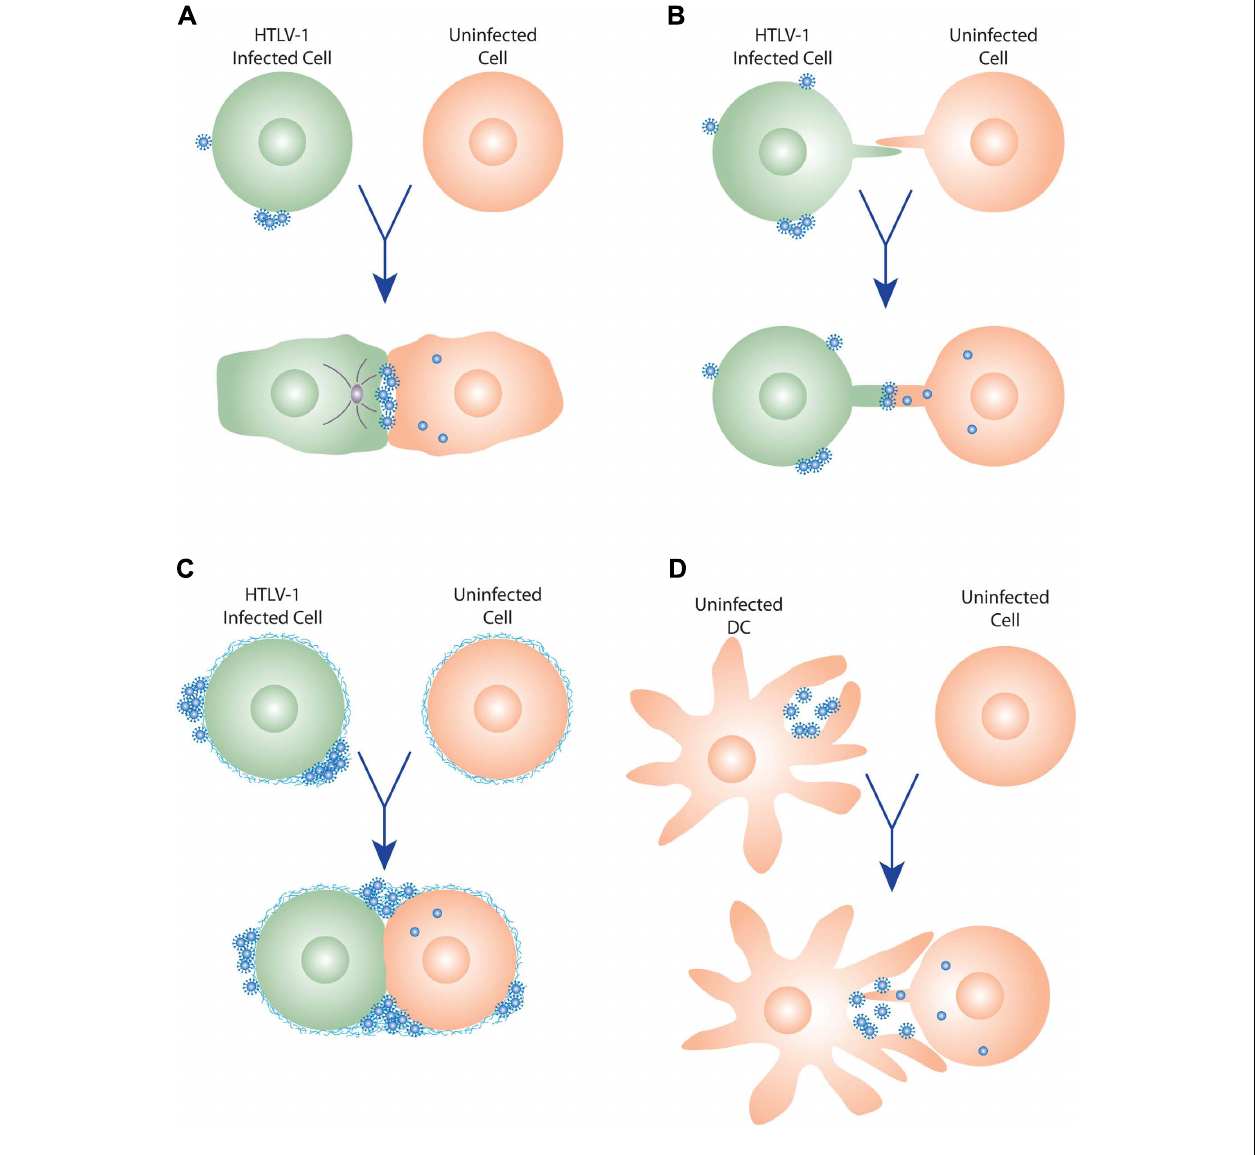
FIGURE 1 | Models of HTLV-1 cell–cell transmission. (A) Virological synapse.When HTLV-1-infected cells contact uninfected cells, the virological synapse (VS) is formed by specific interactions between proteins on the infected and uninfected cells, and the MTOC (gray circle) is reoriented towardVS.Viral budding is polarized to the virological synapse, and the newly budded viruses enter the synaptic cleft formed by theVS, and then enter the target cells following interactions with the cellular receptors. ( B) Cellular conduits. HTLV-1-infected cells can also transfer virus to uninfected cells by transient membrane extensions (cellular conduit). Interactions can occur between conduits on the infected and uninfected cell, or between cells and conduits (not shown), and particles have